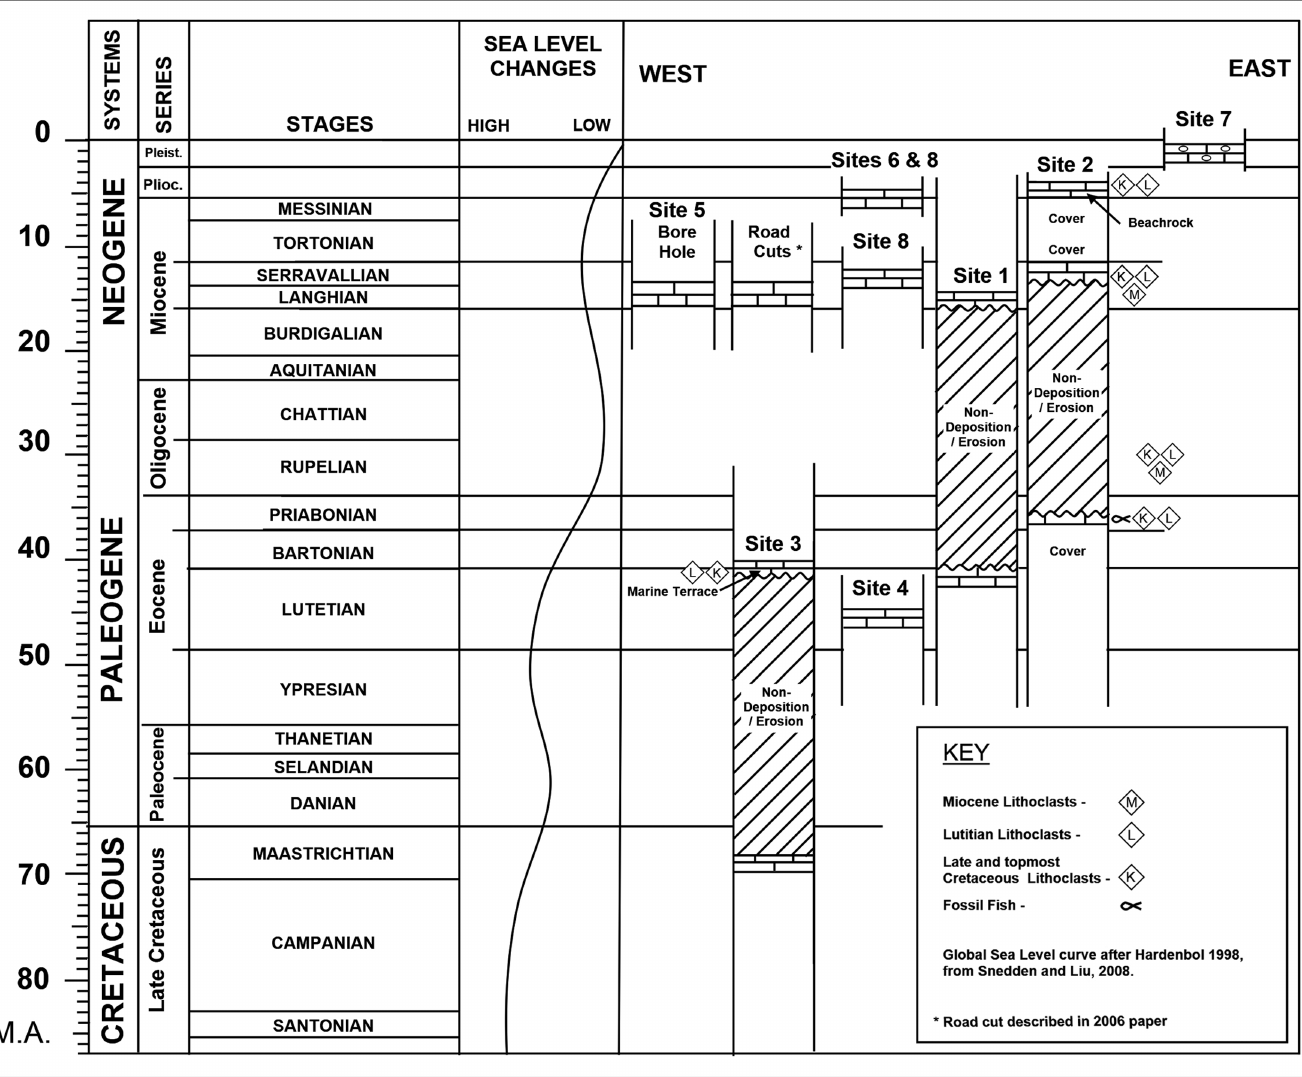
Preserved lithologies of the Eocene and Miocene carbonates of the Beirut harbour area; note occurrences of allochthonous lithoclasts from older reliefs. Global sea level curve after snedden and Liu